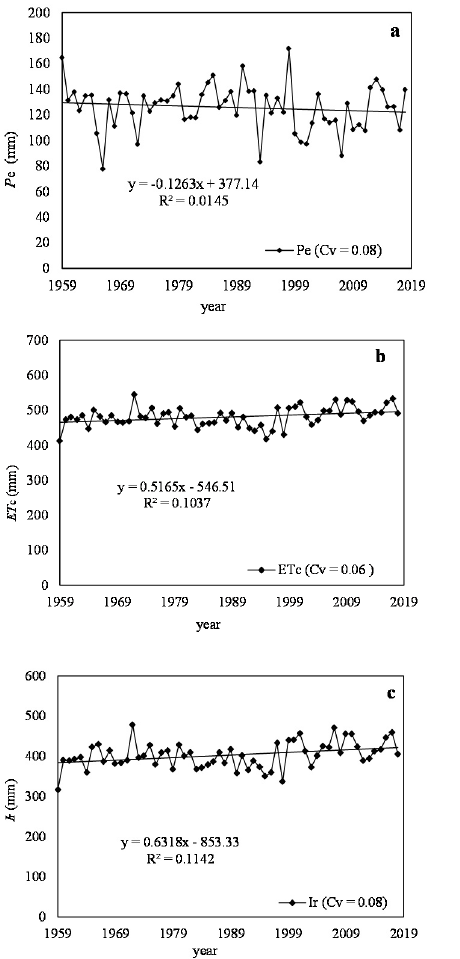
( e ) L late (mm decade − 1 ) Figure 4. Spatial variation characteristics of P e slope during the entire growth period ( a ), early growth period ( b ), rapid growth period ( c ), middle growth period ( d ), and end growth period ( e ) of maize from 1959 to 2018.